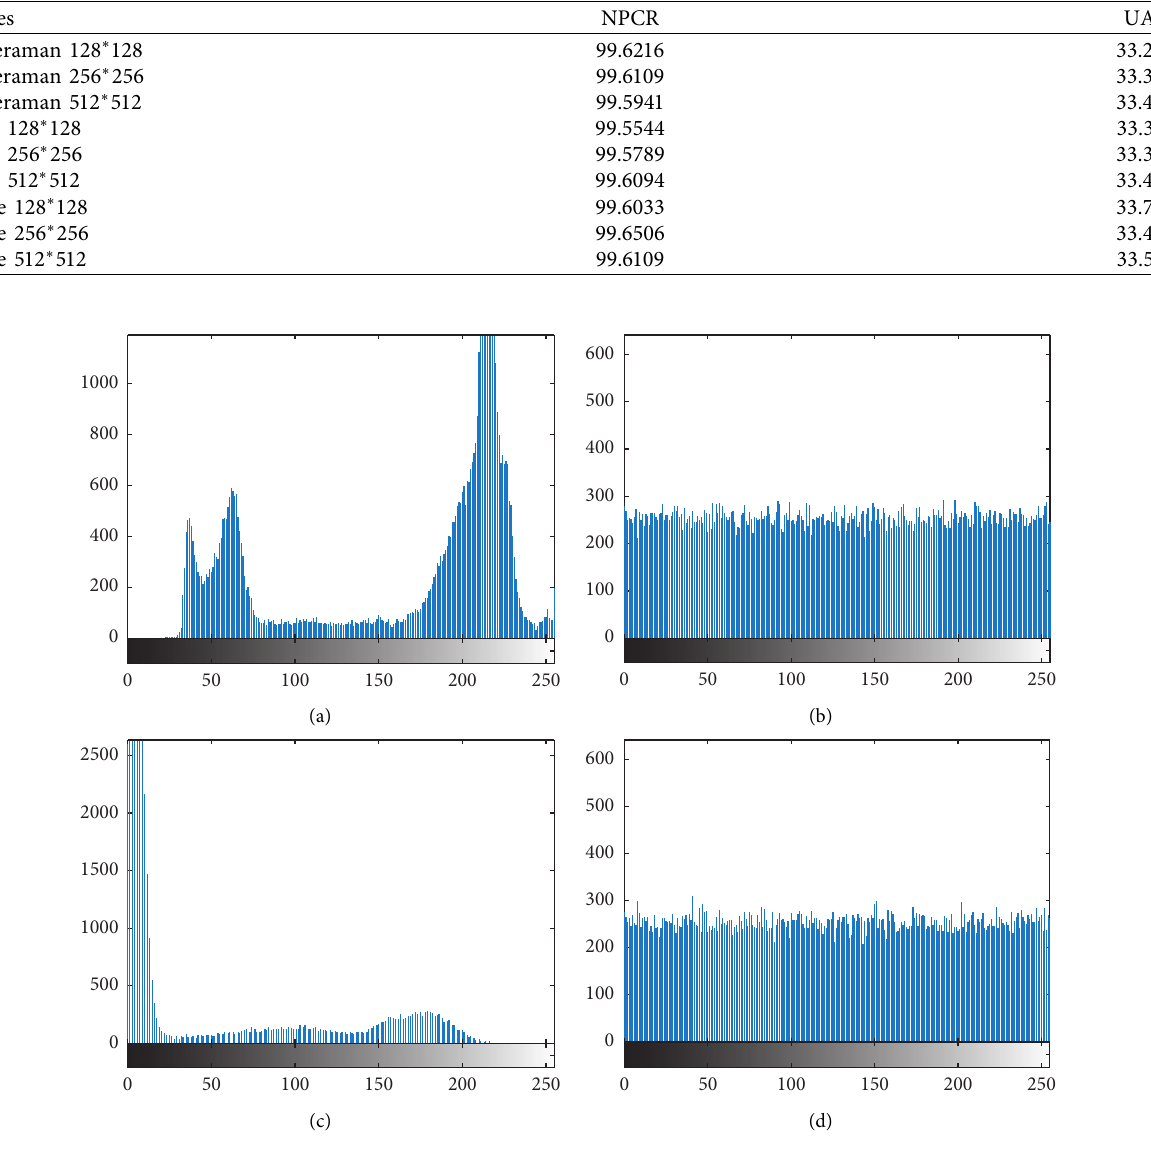
Figure 6: The histogram original images and their cipher images. (a) Histogram of the cameraman 256 × 256 image. (b) Histogram of the cipher cameraman 256 × 256 image. (c) Histogram of the brain 256 × 256 image. (d) Histogram of the cipher brain 256 × 256